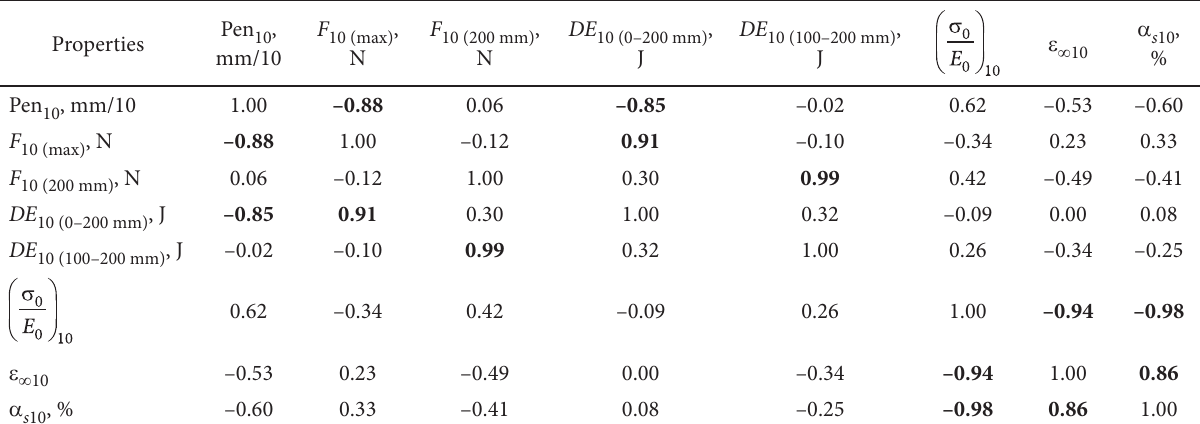
Table 6. Pearson’s coefficient of correlation R values calculated for the relationship between the selected parameters of bitumens determined at 10 °C Properties